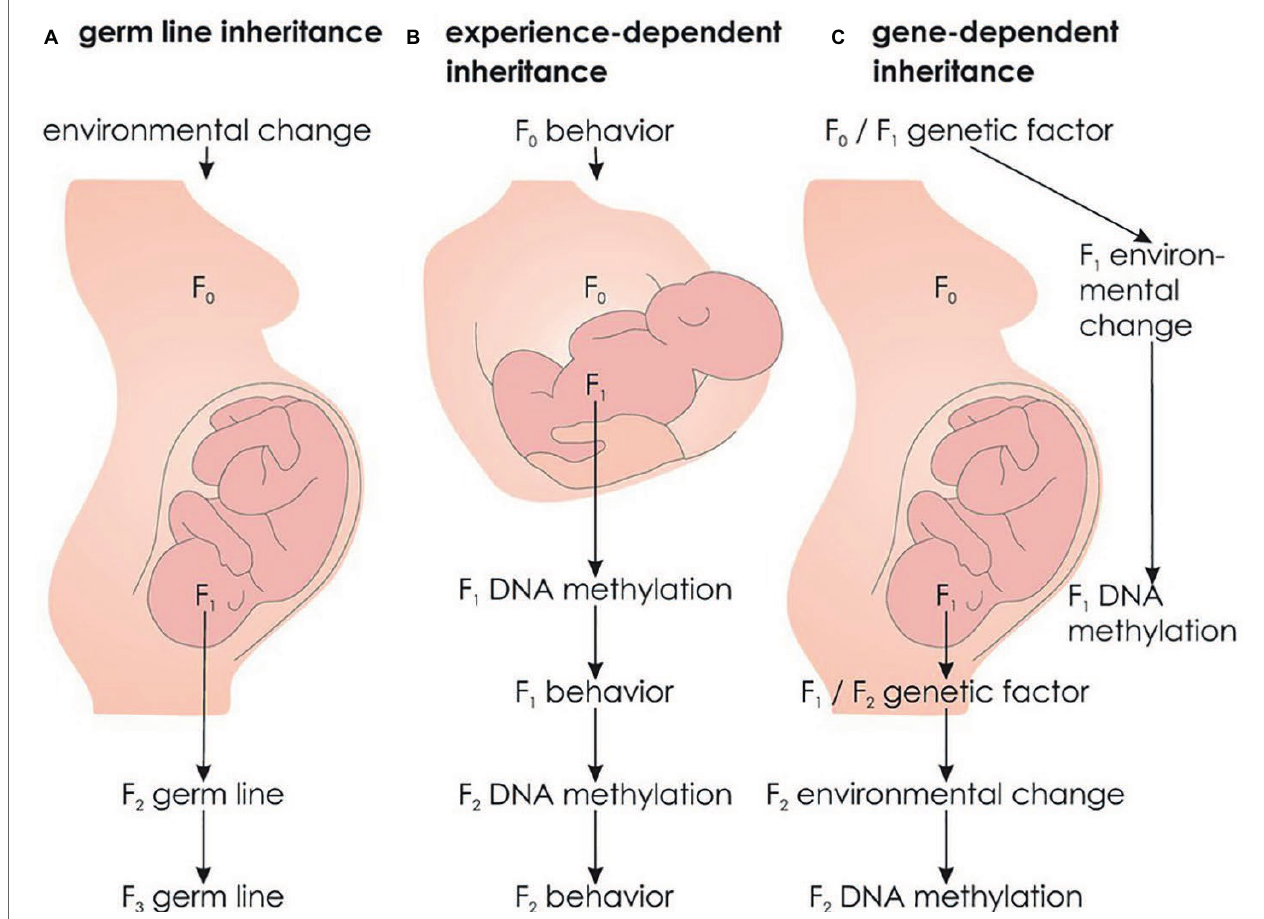
FIGURE 5 | Alternative forms of transgenerational epigenetic inheritance. (A) Germ line epigenetic inheritance: An environmental factor acts on the F 0 generation and induces an epigenetic state that is transmitted to subsequent, unaffected individuals via the germ line. (B) Experience-dependent epigenetic inheritance: Maternal behavior induces an epigenetic state in the offspring (F 1 ) that in turn influences F 1 behavior toward its offspring (F 2 ) transmitting behavior and epigenetic states across generations. (C) Gene-dependent epigenetic inheritance: A genetic factor modulates the probability of an environmental factor that influences F 1 epigenetic states. As F 1 likely transmits the genetic factor to F 2 , epigenetic states are transmitted across